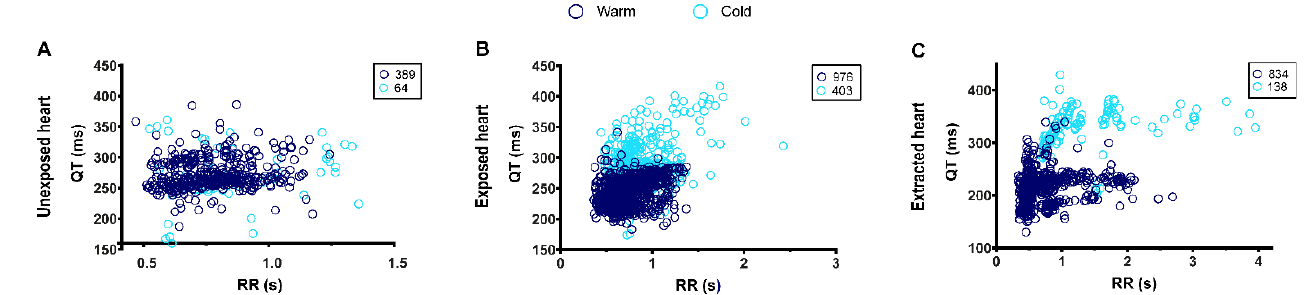
Figure 3. QT-RR relationship in different configurations of ECG measurement. ( A ), Unexposed heart; ( B ), exposed heart; ( C ), extracted heart. The number of individual QT-RR pairs, obtained in warm and cool conditions is presented in the upper right corner of each graph and was obtain from 5 (unexposed heart), 9 (exposed heart) and 7 (extracted heart) fish.